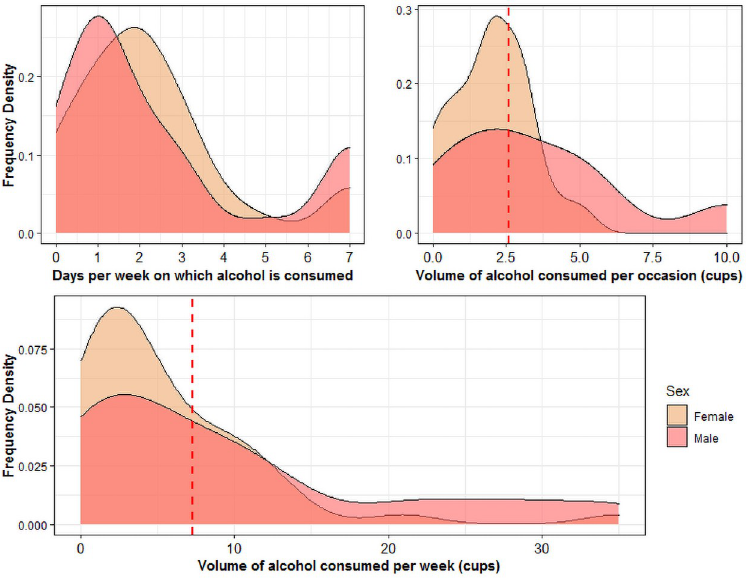
Fig 2. Frequency density curves showing the distribution of alcohol consumption behaviours. Dashed red lines indicate estimate of WHO-defined hazardous drinking.